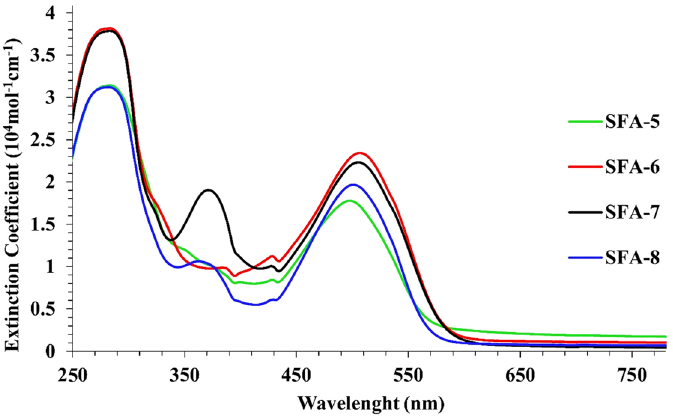
Figure 4. UV–Vis absorption of sensitizers SFA-5–8 measured in THF (2 × 10 −5 M).